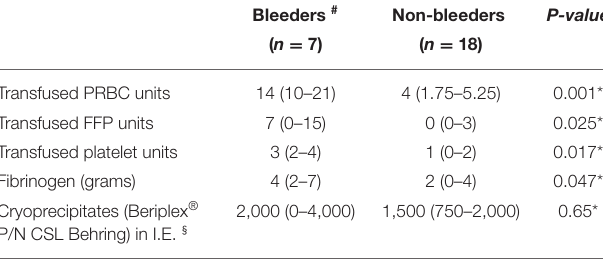
TABLE 3 | Transfused blood products within observation